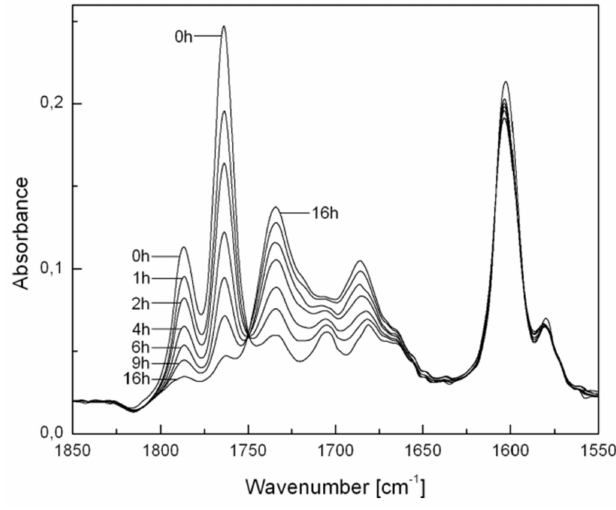
Figure 6. Temporal evolution of FTIR spectra upon thermolysis of BP groups in a preirradiated BZS /S copolymer at 91 ◦ C. The spectral bands of PS have been subtracted from each for clarity.